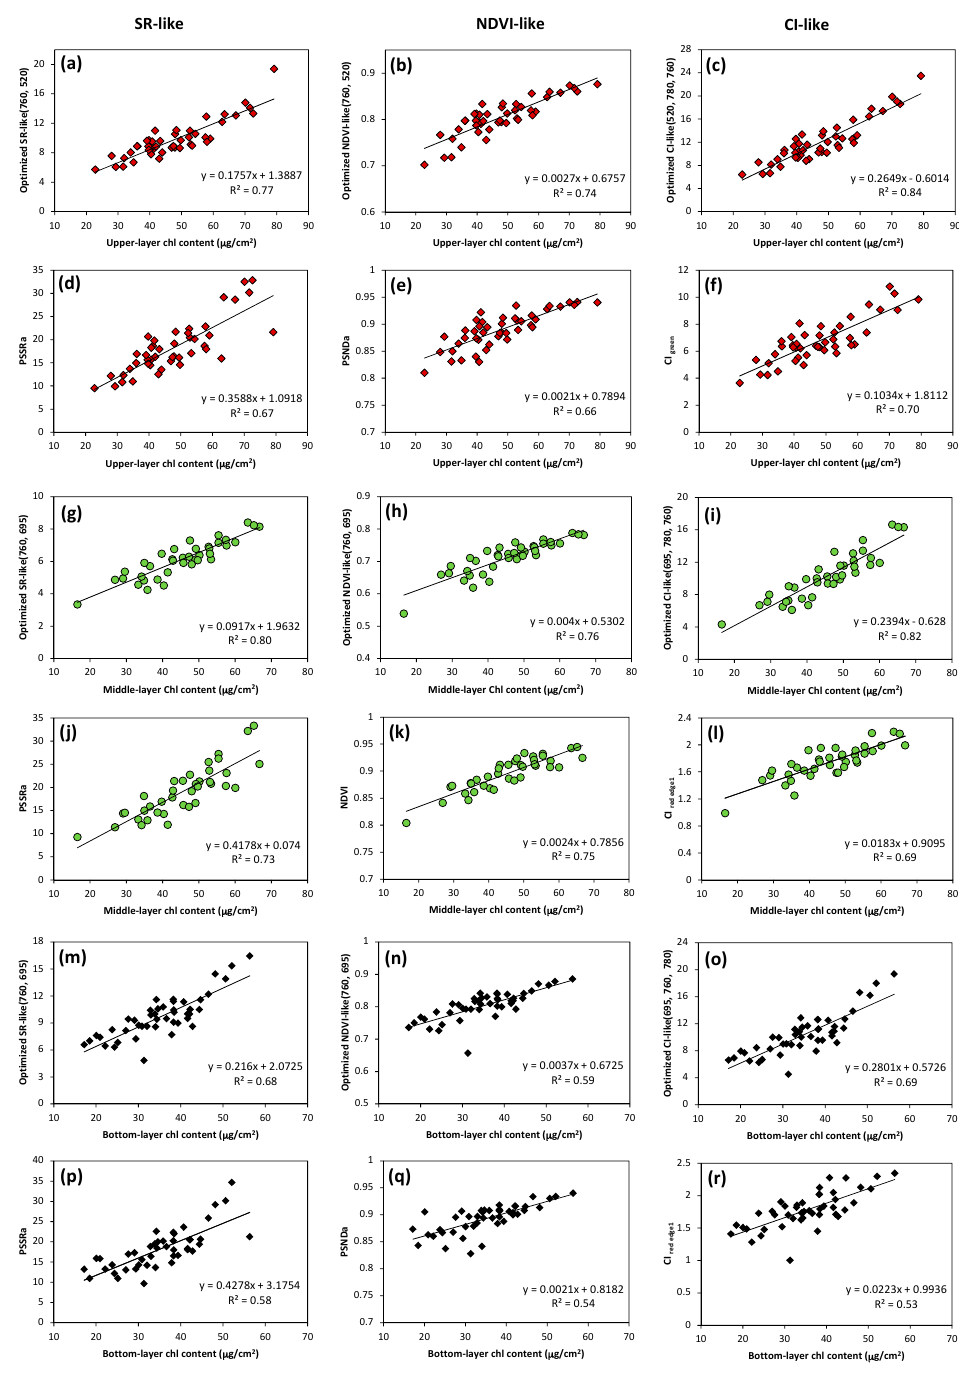
Figure 6. Scatter plots of the relationships between optimized SR-, NDVI- and CI-like types of indices and corresponding types of best performing published indices, versus leaf Chl content in: the upper-layer ( a – f , red diamonds); the middle-layer ( g – l , green circles); and the bottom-layer ( m – r , black diamonds) of wheat canopies.